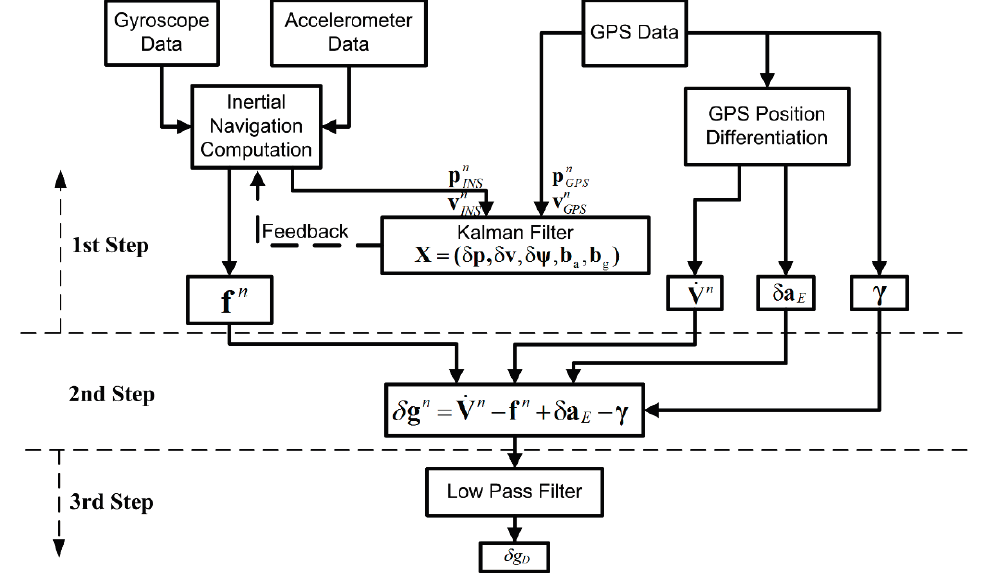
Figure 2. Configuration of data processing for SGA-WZ. The estimated Kalman filter states are position, velocity, attitude, and gyro and accelerometer